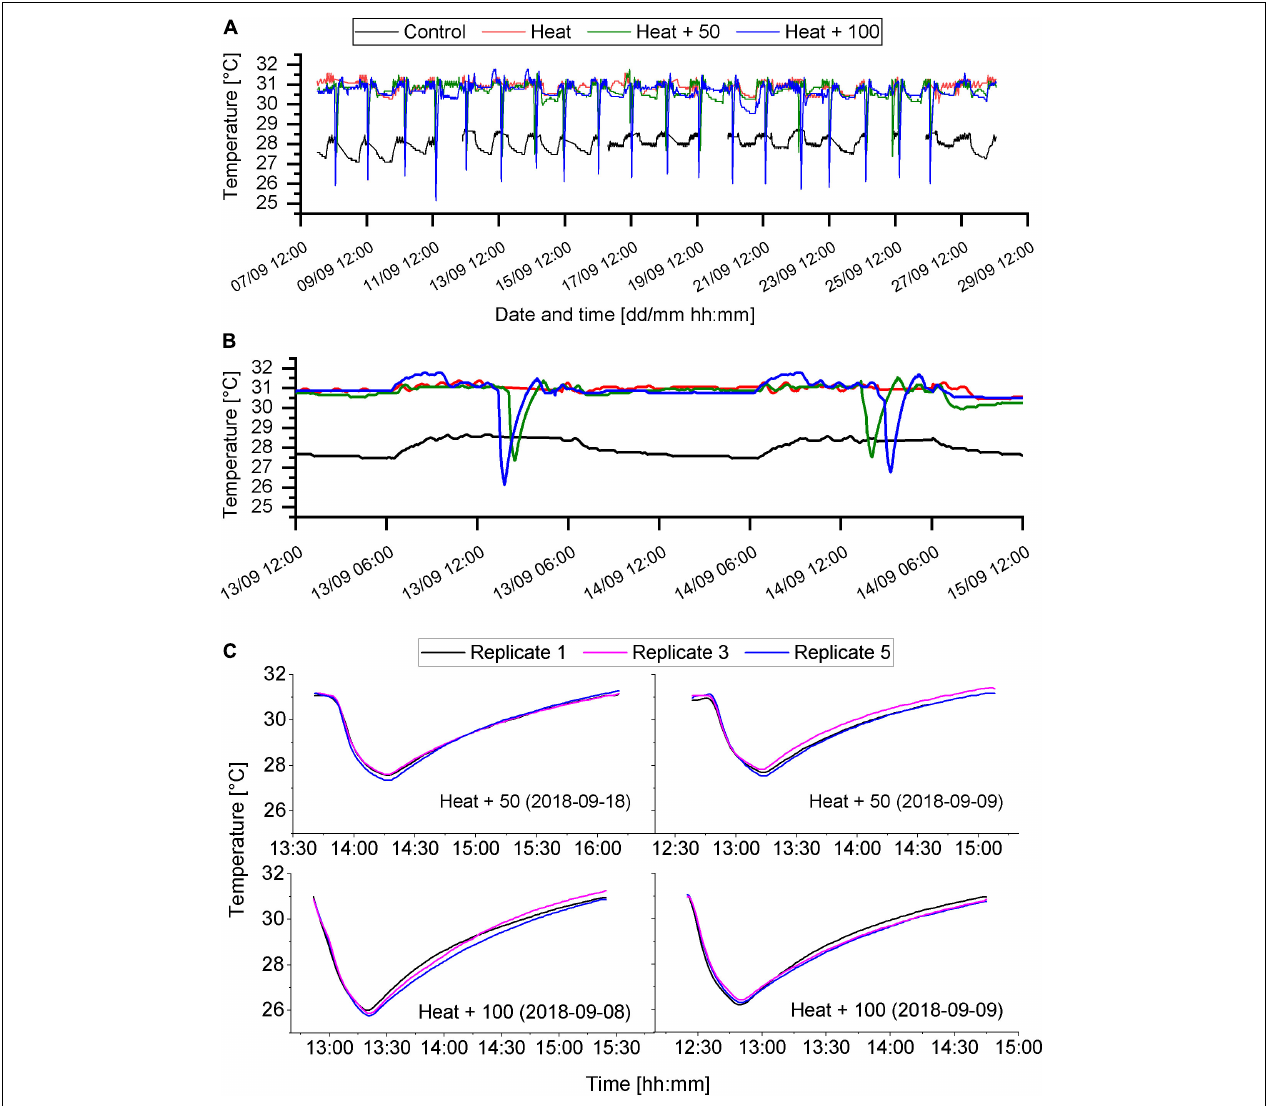
FIGURE 2 | Temperature regimes of the different treatments. (A) Temperature of each of the four treatments throughout the experimental phase (8th to 28th of September 2018). Sudden drops of temperature indicate AU events. Gaps in the data set indicate gaps in temperature recordings. (B) Close up of temperature regime of 2 experimental days (13th and 14th of September). (C) Examples of AU events, showing the temperature of 3 of the 5 replicate